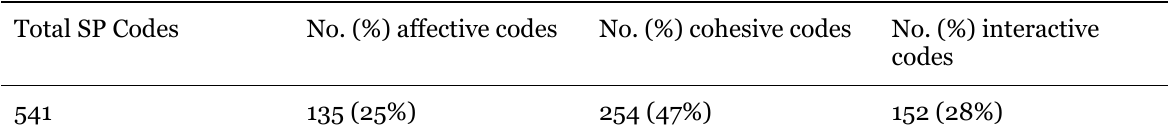
Instructor Social Presence Codes Distribution